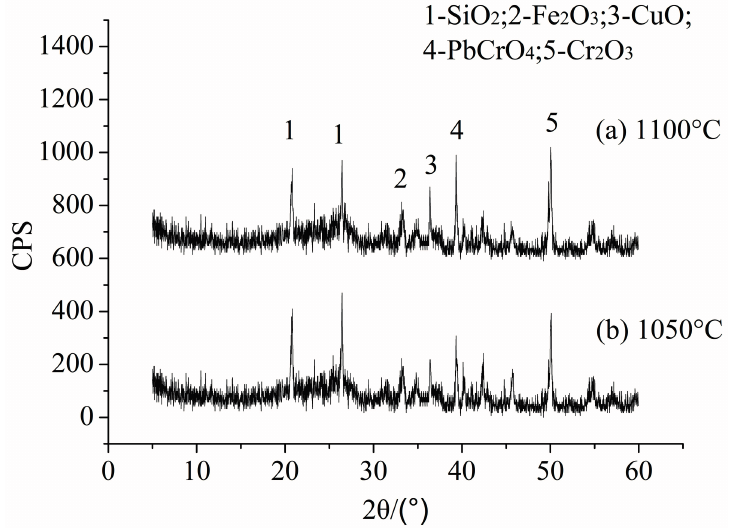
Figure 5. XRD analyses of LWA containing sludge at different sintering temperature: ( a ) 1050 °C; ( b ) 1100